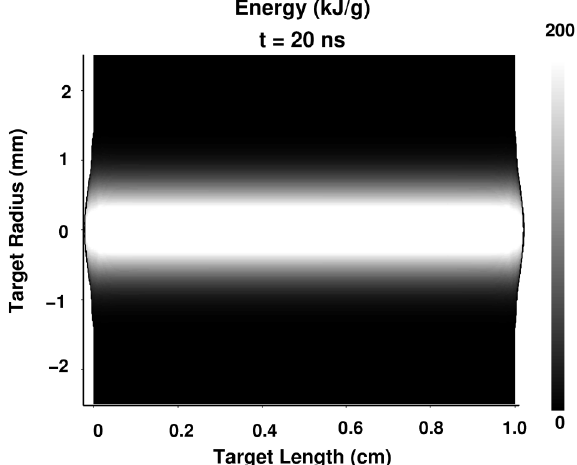
FIG. 5. Specific energy deposition on a length-radius plane employing the beam-target geometry shown in Fig. 4(a), using a uranium beam having 1 : 5 (cid:1) 10 12 particle of 2 : 7 GeV = u uranium, focal spot radius (full width at half maximum) (cid:3) 1 : 0 mm , pulse duration, (cid:11) (cid:3) 20 ns . The target is a cylinder made of solid lead with a length L (cid:3) 1 : 0 cm and radius (cid:3) 2 : 5 mm .